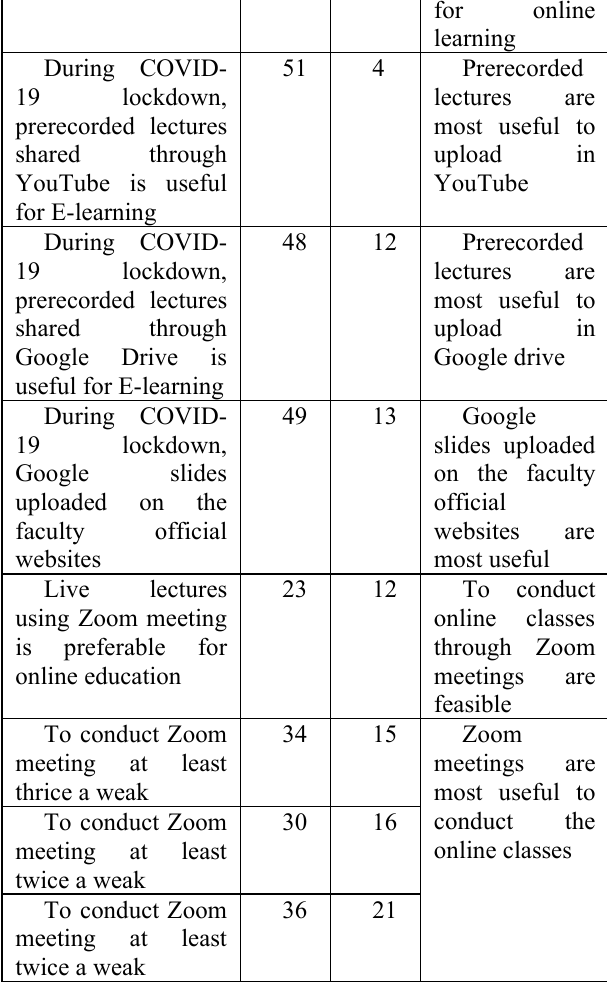
Table 6. Learners responses to the survey